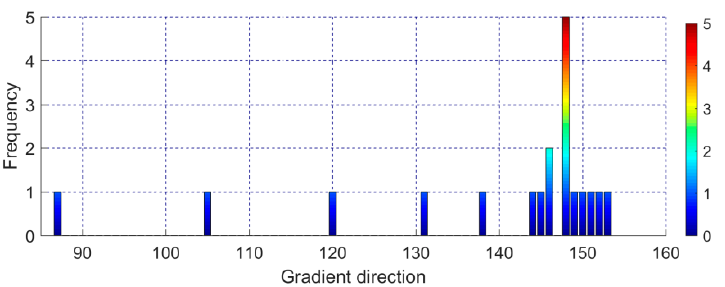
Figure 7. The histogram of the gradient directions. The horizontal axis means the direction of the gradient (Unit: degree ), and the vertical axis represents the number of occurrences.